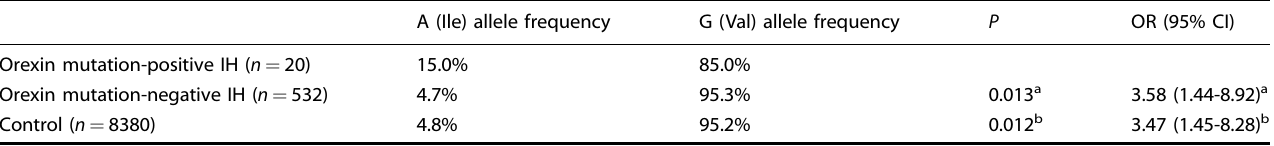
Table 3. Signi fi cant association between orexin mutation-positive IH and a common missense variant (rs2653349, p.Ile308Val) in orexin receptor-2 ( OX2R